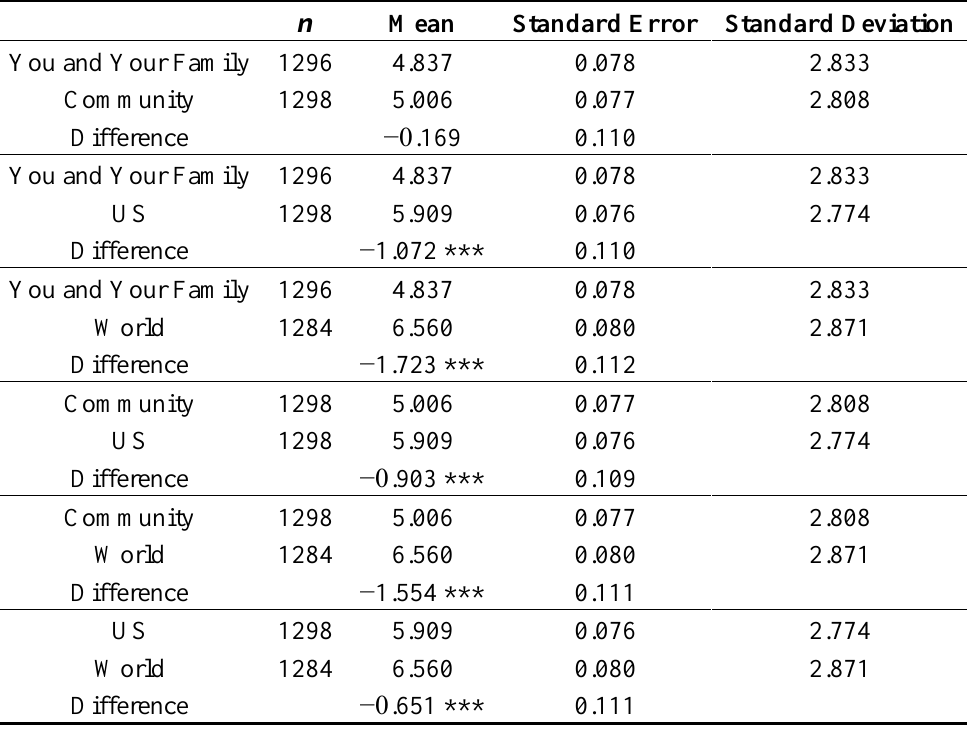
Table 1. Comparison of Health Risk